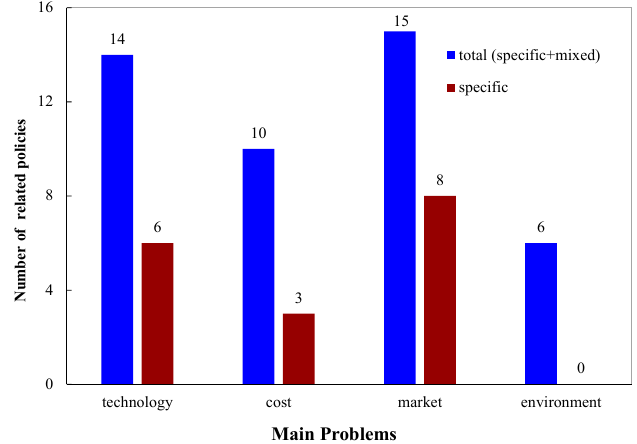
Figure 1. Issued policies covered all the main problems but to different degrees.